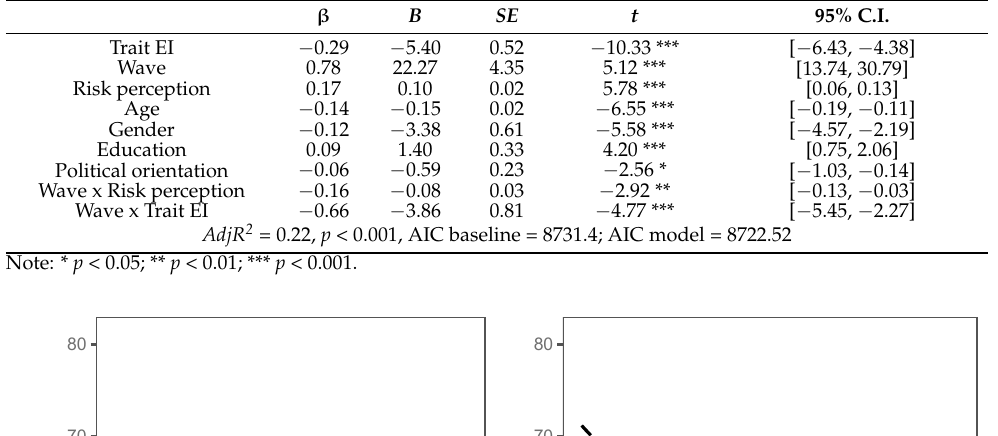
Table 3. Regression model predicting participants’ state anxiety.